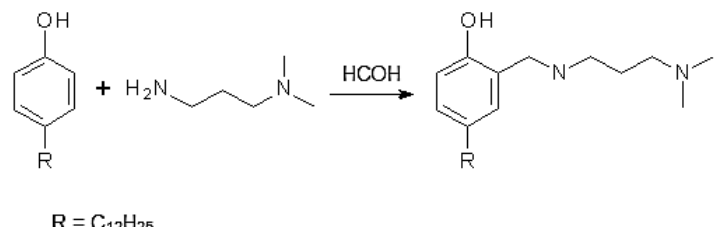
Figure 4. Scheme of the 2-(((3-dimethylaminopropyl)amino)methyl)-4-dodecylphenol (DEM2) synthesis reaction.